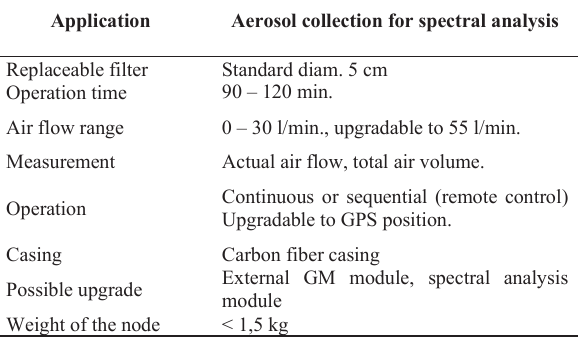
Fig. 3. DJI matrice 600 with the RMS